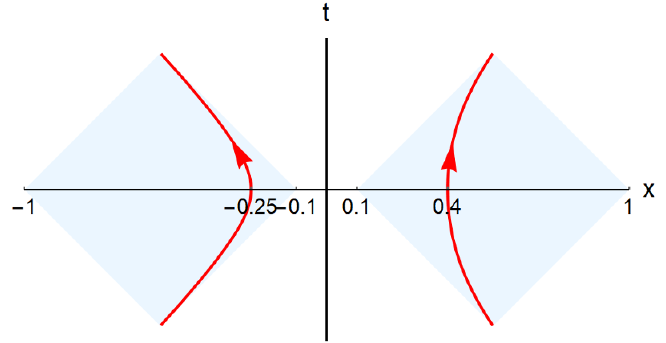
Figure 4 . An example with the region [ (cid:0) 1 ; (cid:0) 0 : 1] [ [0 : 1 ; 1] and z (0) (cid:25) 0 : 336. The causal diamonds of the two intervals are shaded in blue. Under the modular (cid:13)ow, the two fermion operators travel along the red curve while mixing with each other. The positive (cid:28) direction is marked by the arrow. Note that the red curves are not generated by the conformal Killing vectors inside each